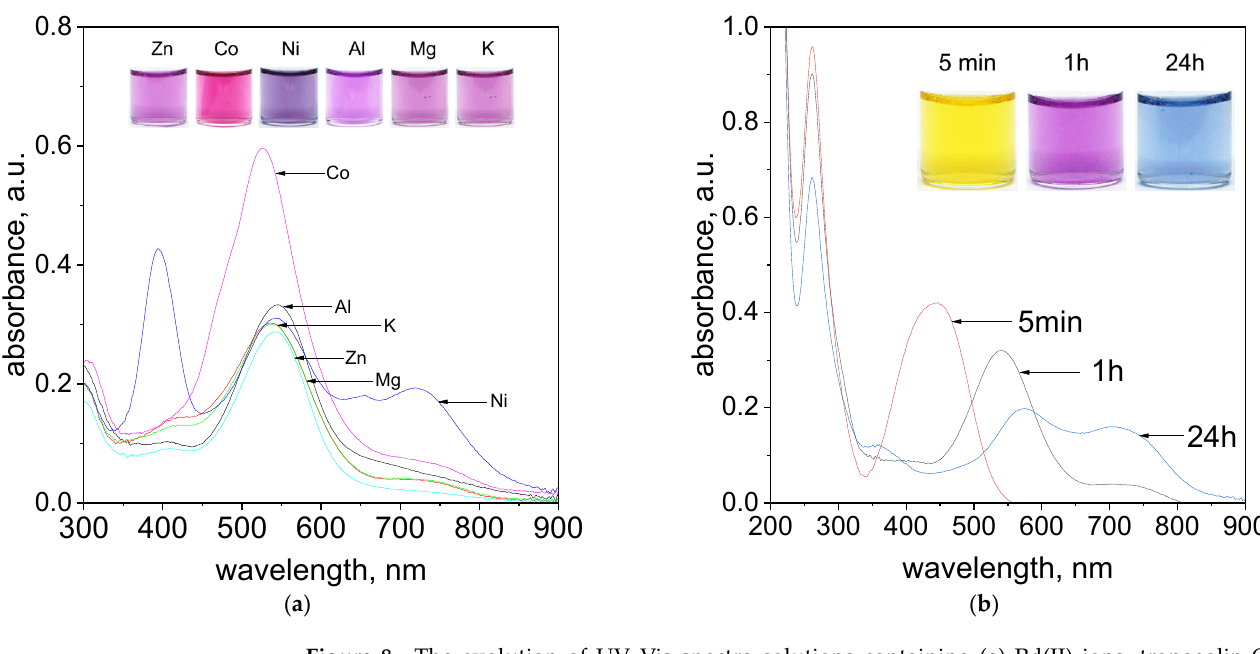
Figure 8. The evolution of UV–Vis spectra solutions containing ( a ) Pd(II) ions, tropaeolin OO and other metal cations: Zn 2+ , Ni 2+ , Mg 2+ , K + , Co 2+ , Al 3+ , after 1h at temperature 50 °C, ( b ) Pd(II)/Pt(II) ions and tropaeolin OO, after 5 min, 1 h, 24 h, at temperature 50 °C. Conditions: C 0TR = 1.875 × 10 − 5 mol/dm 3 , C 0Pd(II)/Pt(IV) = 3.125 × 10 − 5 mol/dm 3 C 0,anions = 0.0625 mol/dm 3 , volumetric ratio mixing Pd(II) ions and tropaeolin OO 2.5 mL: 1.5 mL, pH = 4.10.